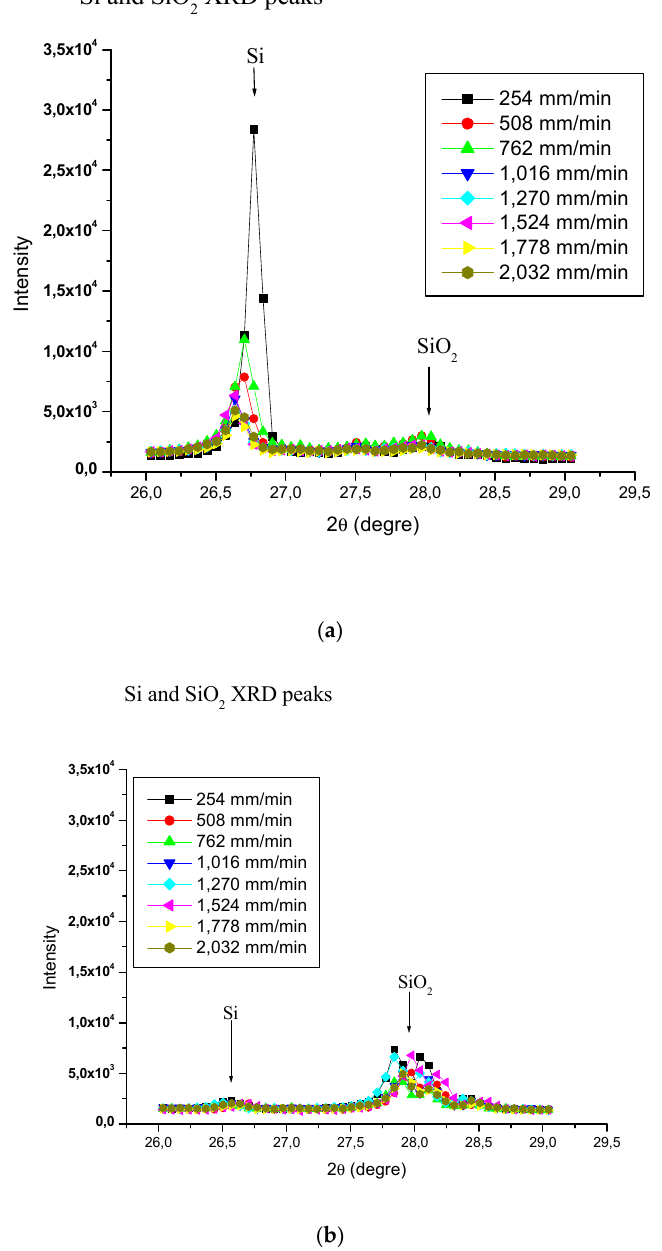
Figure 4. XRD patterns obtained at different feed rates for ( a ) white granite, and ( b ) Black granite (Canadian anorthosite), using 1000 rpm polishing rotation speed, 0.2 bar pressure and 60 grit abrasive.